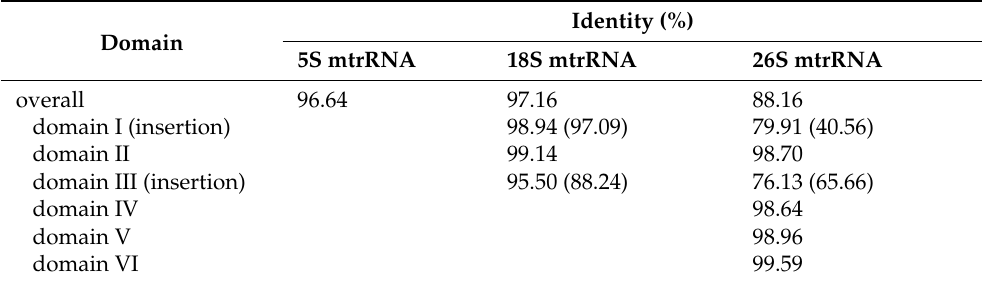
Table 6. Identities of mtrRNA between S. plumbizincicola and H. parviflora